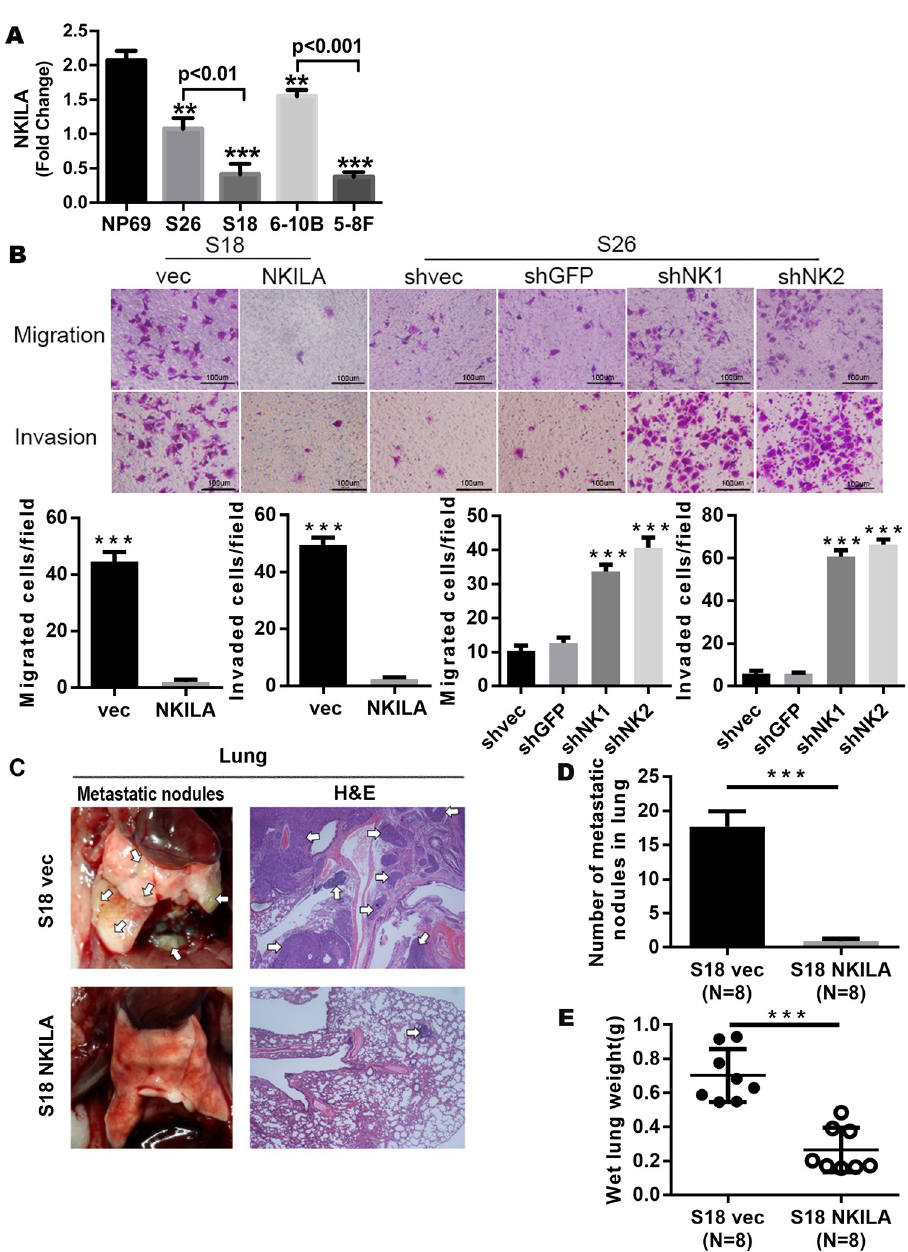
Fig 5. NKILA repress the metastasis of NPC by inhibiting the NF-kB pathway. (A) NKILA expression in NPC cell lines determined by qRT-PCR assay (Mean ± SD, n = 3, ��� , P < 0.001, �� , P < 0.01versus NP69). (B) Representative images of migrated and invaded NPC cells with overexpressed or silenced NKILA in Boyden chamber assay (Mean ± SD, n = 3, ��� , P < 0.001, versus control). (C) Representative images of the lung metastasis, metastatic nodes were indicated by Arrowheads. Left: Representative lungs, Right: Representative image ( × 200) of lung with metastasis by H&E staining. (D) 6 weeks after tail vein injection, number of metastases in lungs of each mice (mean ± SD) were calculated. (E) The wet lung weight of the mice treated with the control vehicle was significantly higher, suggesting that mouse in control group had more or greater metastases, indicating that NKILA inhibited tumor